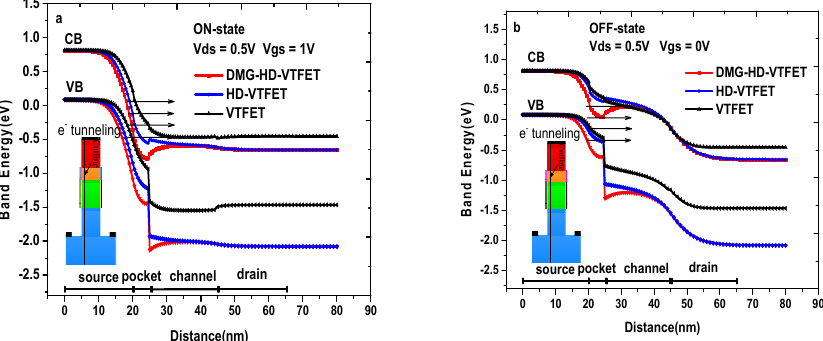
Figure 4. ( a ) The ON-state energy band diagram of VTFET, HD-VTFET, and DMG-HD-VTFET; ( b ) the OFF-state energy band diagram of VTFET, HD-VTFET, and DMG-HD-VTFET.